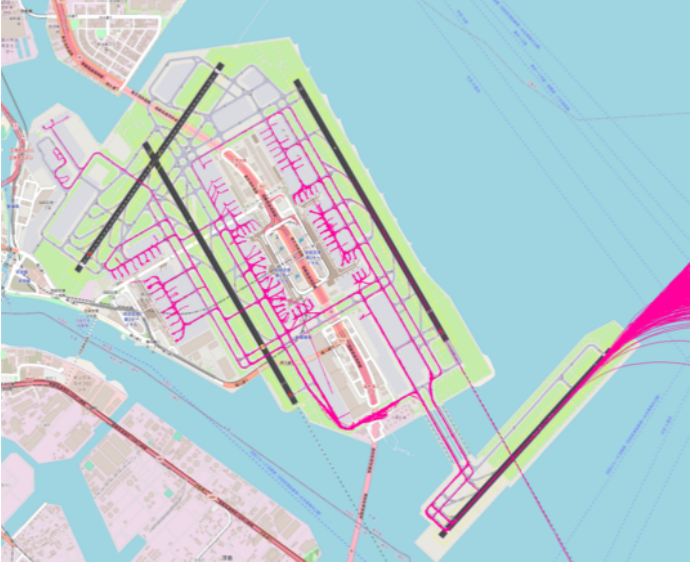
Figure 3. RJTT departures from Runway 05. Table 1. Rate of departure counts corresponding to the aircrafts with less than 5 knot ground